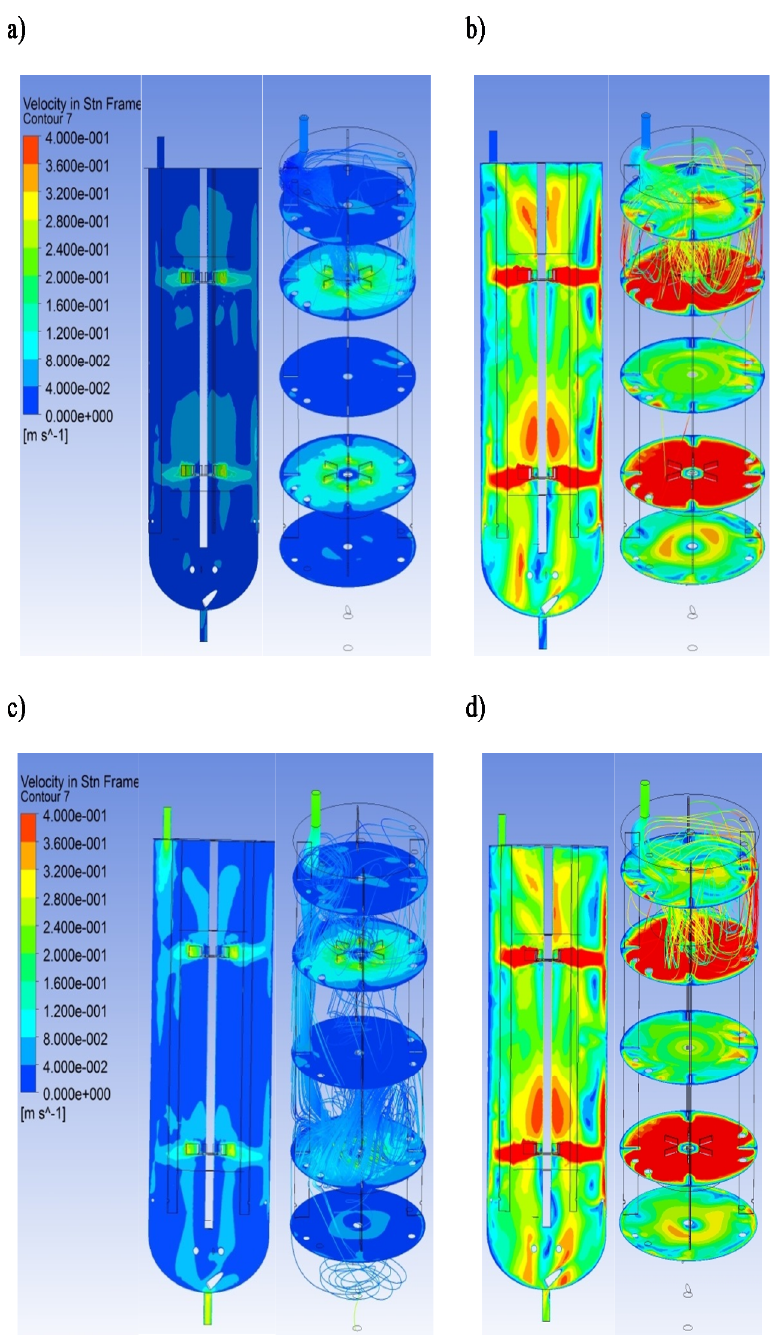
Figure 4. The typical example of the velocity field and overall flow pattern for the tested bioreactor in vertical and horizontal planes: ( a ) V = 10 dm 3 ∙h −1 and N = 100 RPM; ( b ) V = 10 dm 3 ∙h −1 and N = 600 RPM; ( c ) V = 60 dm 3 ∙h −1 and N = 100 RPM; ( d ) V = 60 dm 3 ∙h −1 and N = 600 RPM.